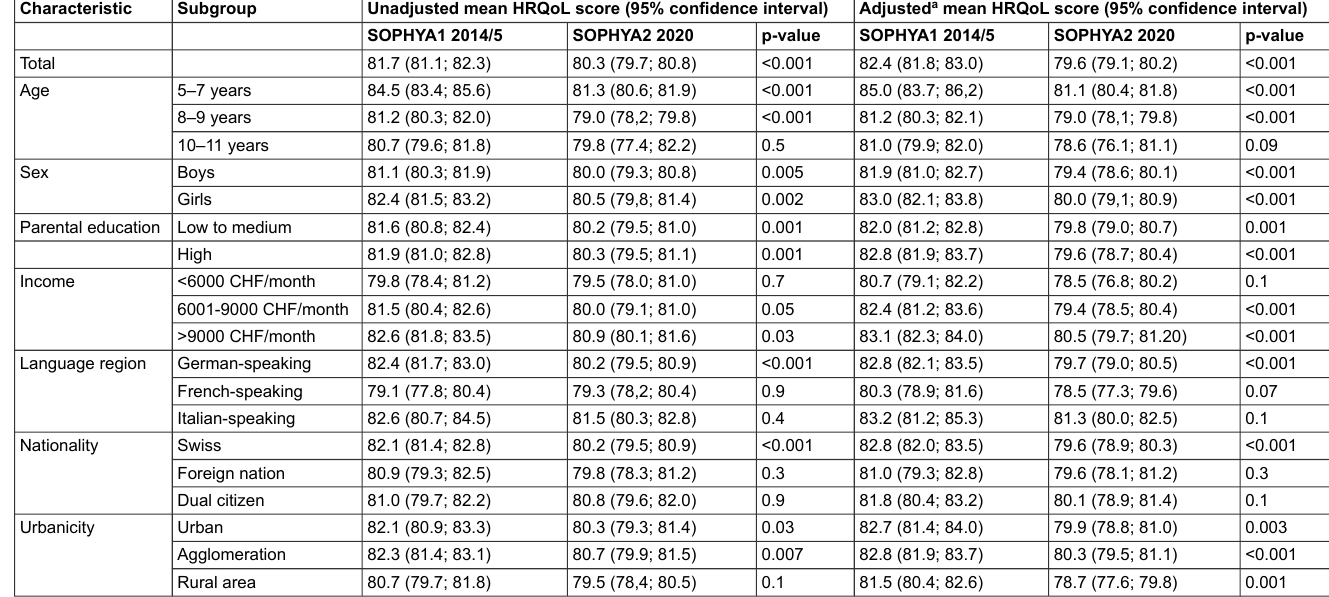
Table 2: Comparison of mean health-related quality of life (HRQoL) scores in 2014/15 versus 2020 (year of COVID-19 pandemic) according to socioeconomic subgroup.